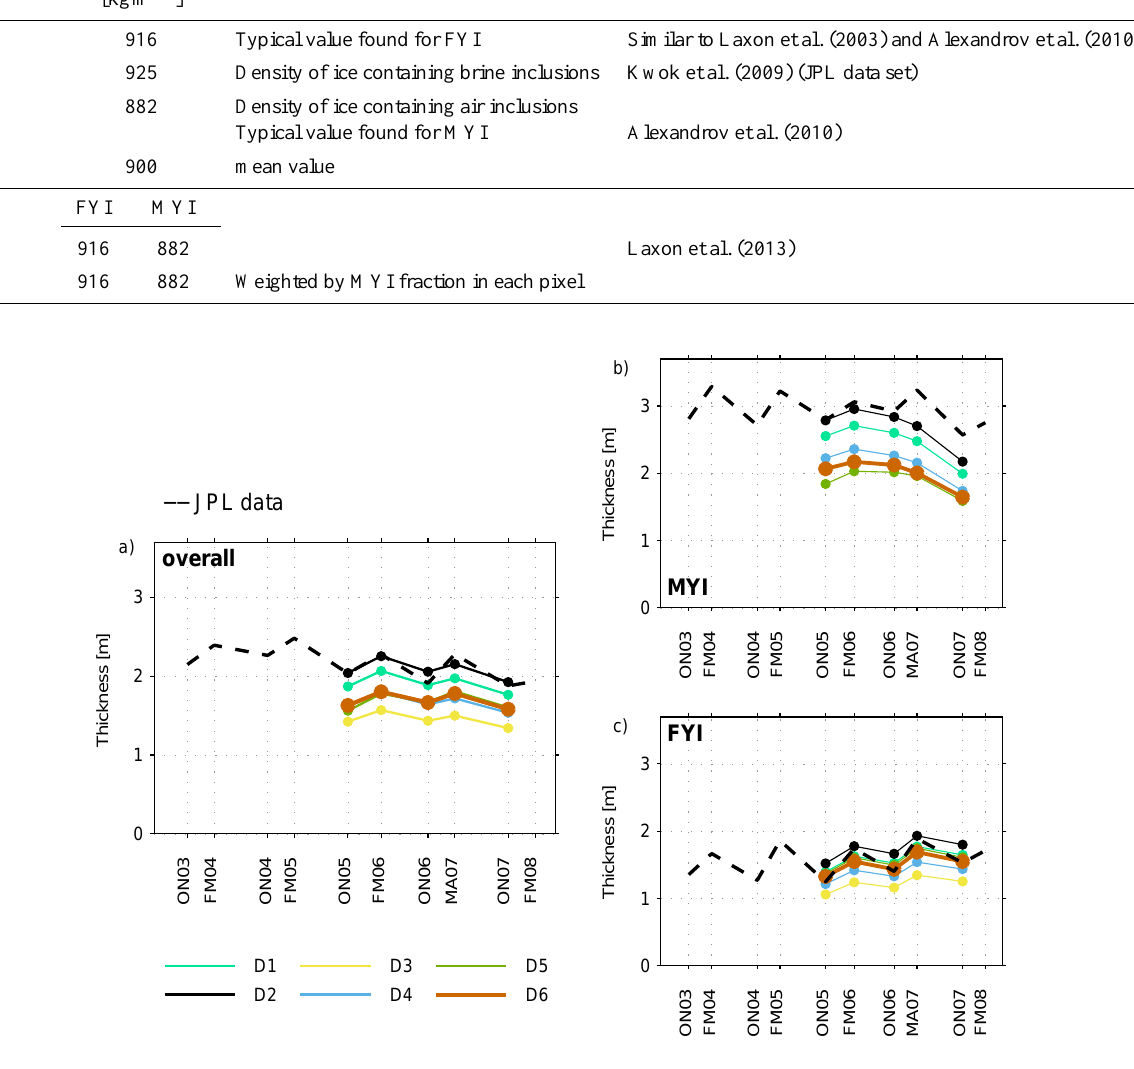
Fig. 3. Spatially averaged Arctic sea ice thickness calculated with different values for ice density. In (a) the total mean thickness is shown, in (b) the thickness of multi-year ice (MYI) and in (c) the thickness of first-year ice (FYI). Density values used are described in Sect. 3.2 and can be found in Table 3. The brown line (D6) is the same as S3 in Fig.